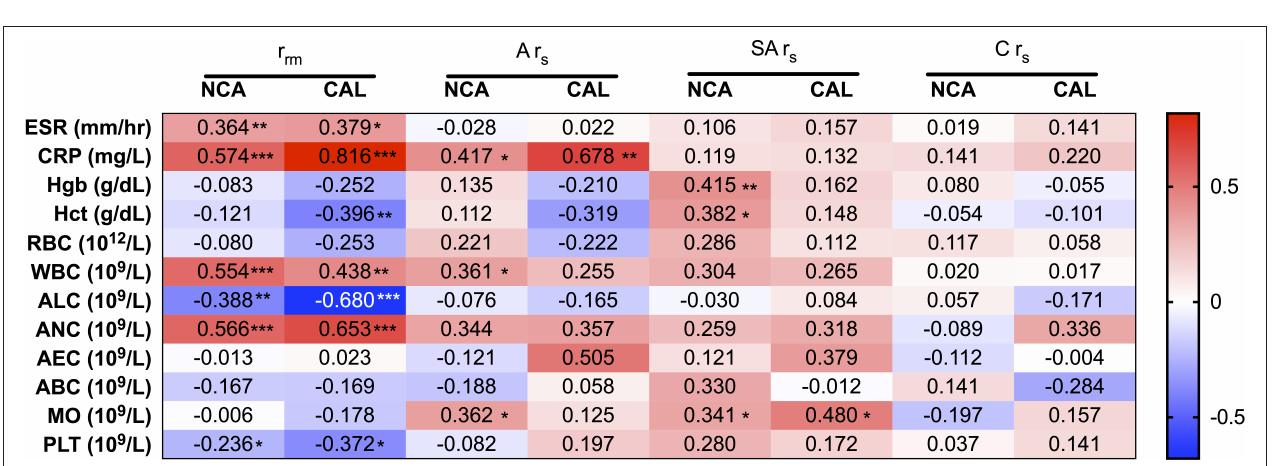
positive r s between PTX-3 and MO in both the NCA and the CAL groups. In the NCA group, sub-acute phase r s analysis between PTX-3 and Hgb and Hct showed weak positive relationships. Furthermore, there were no r s between PTX-3 and the clinical parameters of inflammation in the convalescent phase for the NCA and the CAL groups ( Figure 4